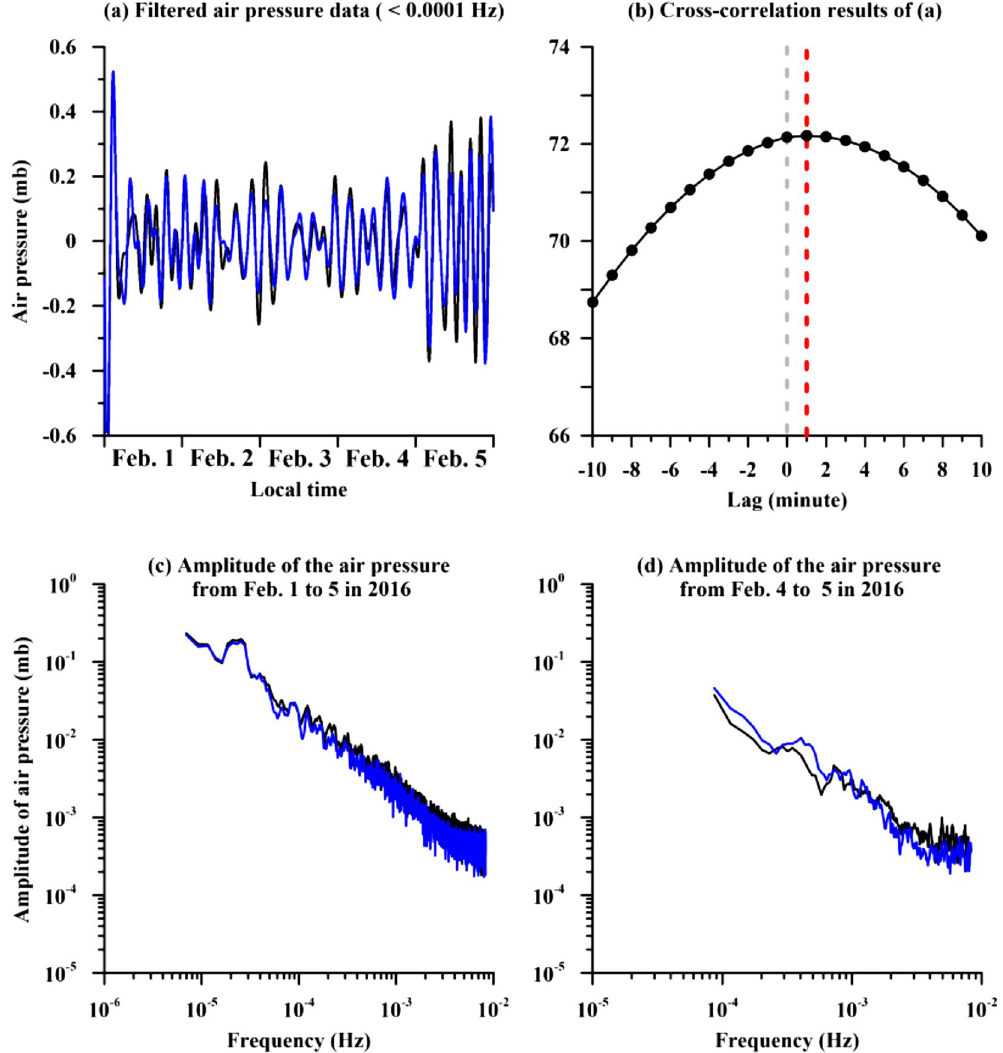
Figure 2. The power spectra of the air pressure data at the SBCB and Xinwu stations and their cross-correlation results in the particular frequency band. The air pressure data retrieved from two studied stations are filtered by using a low-pass filter of 10 –4 Hz shown in ( a ). The cross-correlation results of the filtered data are shown in ( b ). The air pressure data during February 1–5 and February 4–5 in 2016 are transferred into the frequency domain shown in ( c ) and ( d ), respectively. Notably, the black and blue lines denote variations of the amplitudes with a running average of 5 continuous points at the Xinwu and SBCB stations,